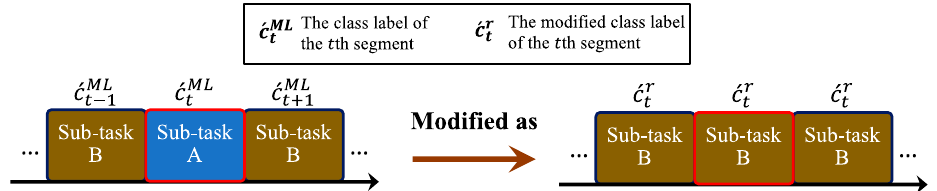
Figure 5. An illustration of the modification process to the fragmentation errors. The “sub-task A” of ´ c t is the misidentified result that is modified as “sub-task B” according to the proposed rule-based modification.